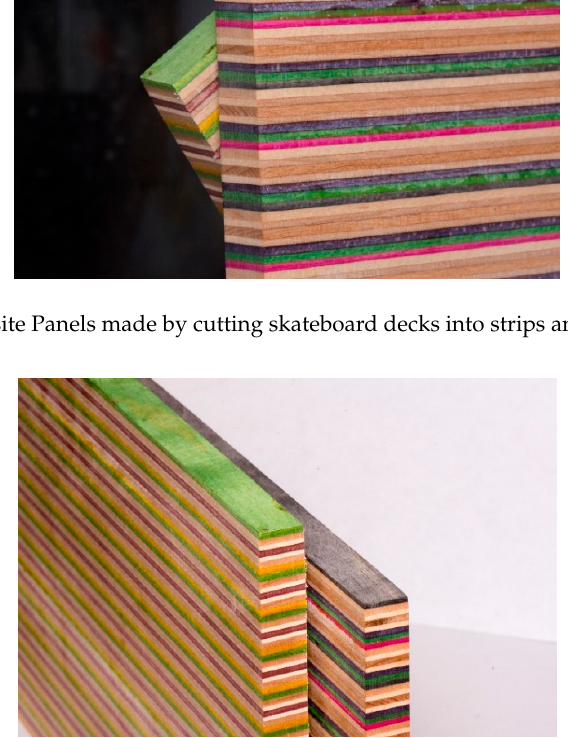
Figure 6. Another view of the composite panels in Figure 5. Note the colorful veneers dyed by the skateboard manufacturers for aesthetics.